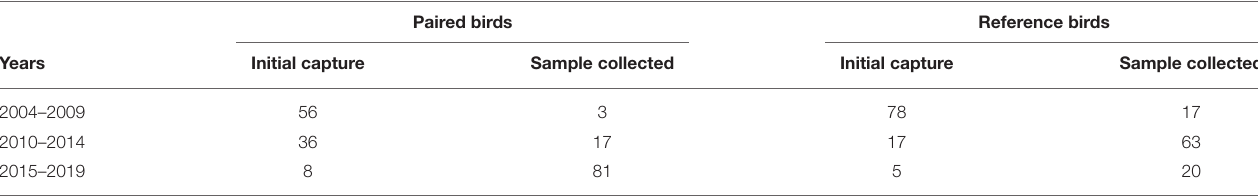
TABLE 1 | Number of birds and samples collected at three-time intervals for paired and reference Ponui Island birds in this study, illustrating that the majority of birds were initially caught at least 10 years ago. Paired birds Reference birds Years Initial capture Sample collected Initial capture Sample